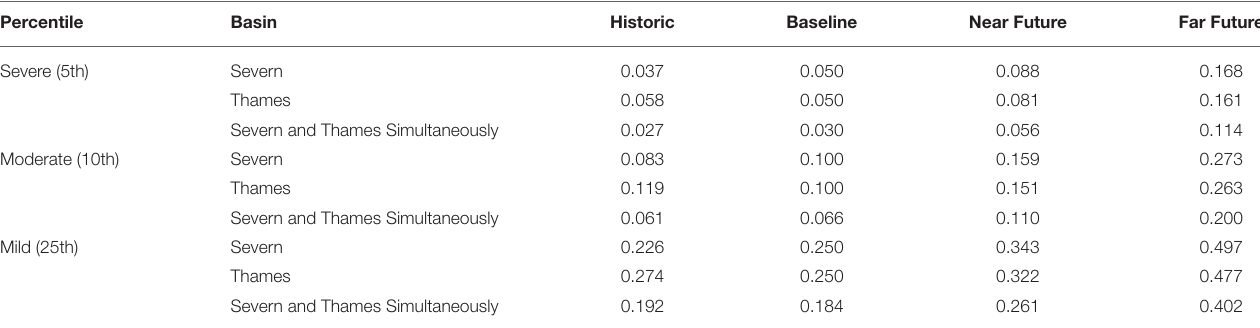
TABLE 4 | Probability of months in historic (CEH GEAR), Baseline, Near Future, and Far Future ensembles with 12-months SPI values < W@H Baseline 5, 10, and 25th percentiles for Thames and Severn study areas, individually and simultaneously.